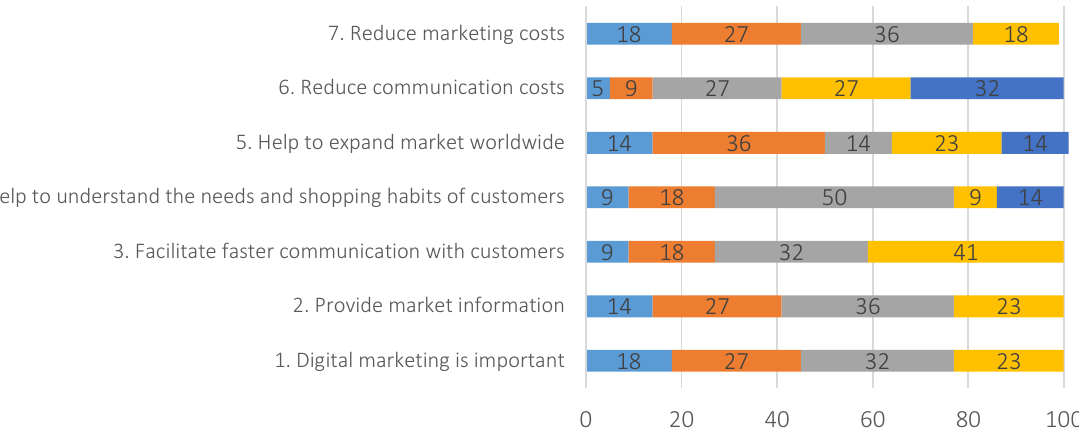
Figure 3. Opinions of institutions about the role of digital marketing application